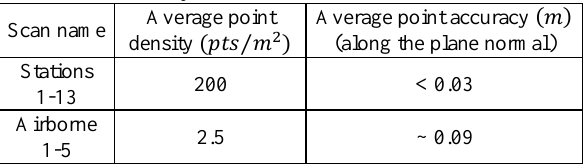
Table 1: A summary of the scans used and their characteristics